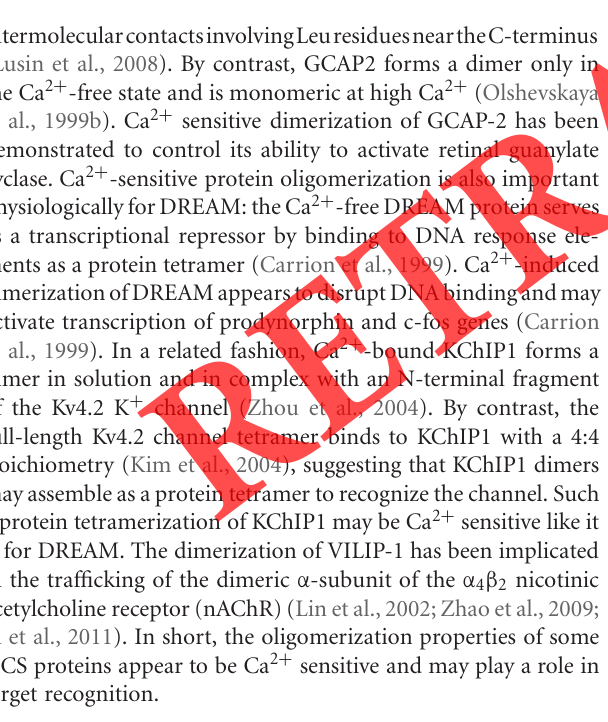
FIGURE 6 | Space-filling representations of the Ca 2 + -bound structures of recoverin (A), frequenin (B), neurocalcin (C), and KChIP1 (D). Exposed hydrophobic residues are yellow, neutral residues are white, and charge residues are red and blue.